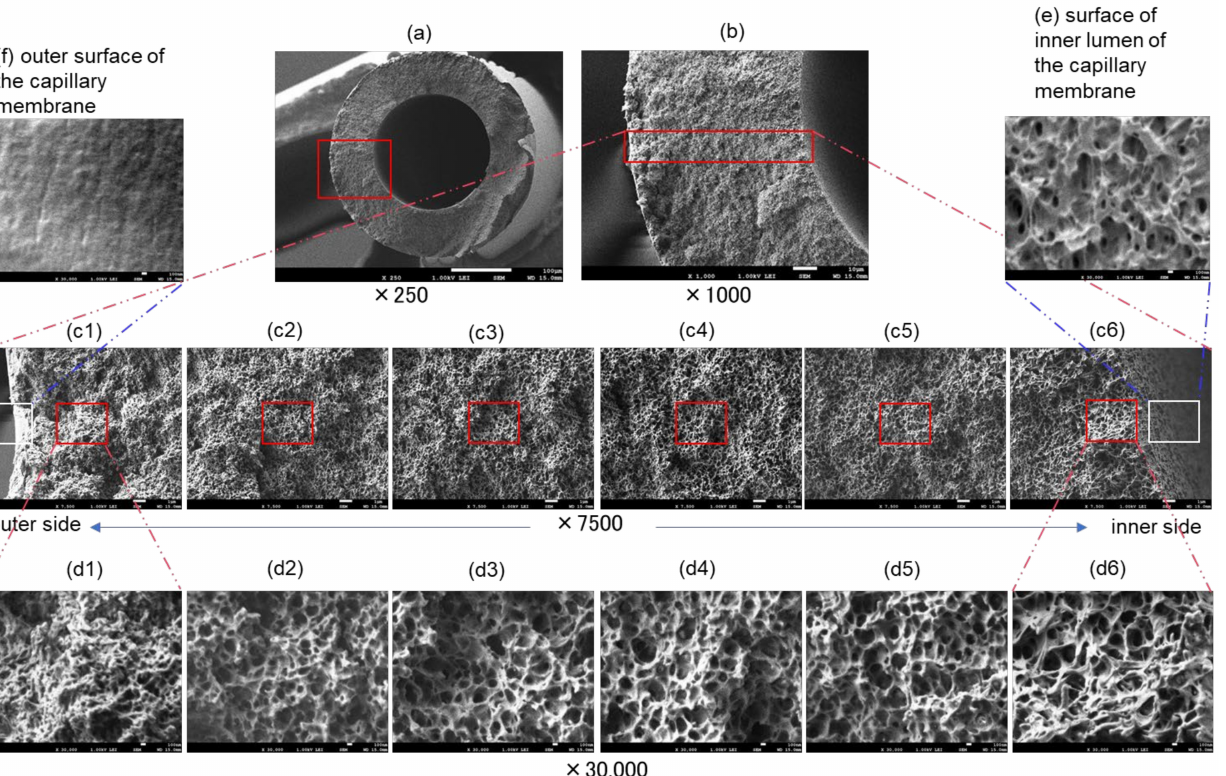
Figure 3. FE-SEM images of Capiox ® LX2(dry), ( a – d ) cross sections and ( e ) inner and ( f ) outer surfaces of the capillary membrane. Magnifications are ( a ) × 250, ( b ) × 1000, ( c ) × 7500 and ( d – f ) × 30,000, respectively. Figure 4 is the FE-SEM images of the cross sections and inner and outer surfaces